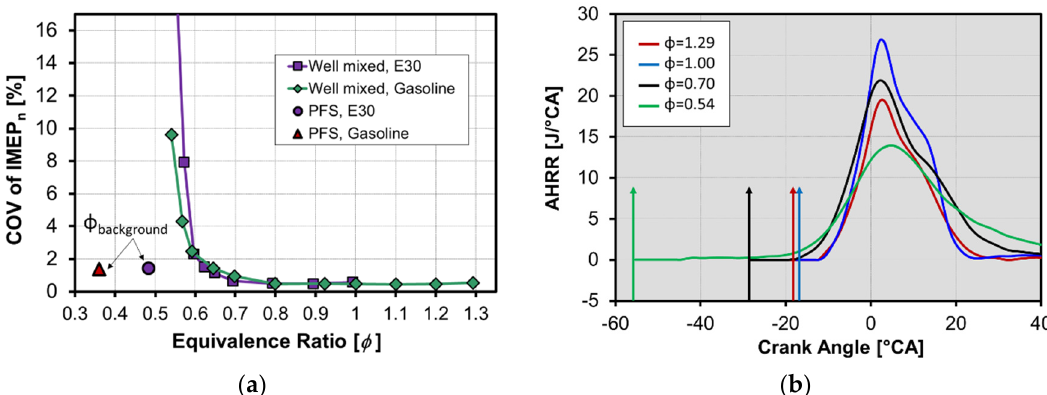
Figure 1. ( a ) COV of IMEP n for well mixed E30 and gasoline at different φ ’s (with T in = 30°C) and for PFS at the conditions investigated in the present paper; ( b ) AHRR for gasoline in well-mixed conditions. The spark timing for each condition is indicated as a vertical arrow. The gasoline fueling rate of 15.6 mg/cycle was kept constant while the intake pressure varied between 37 and 77 kPa to change the φ .